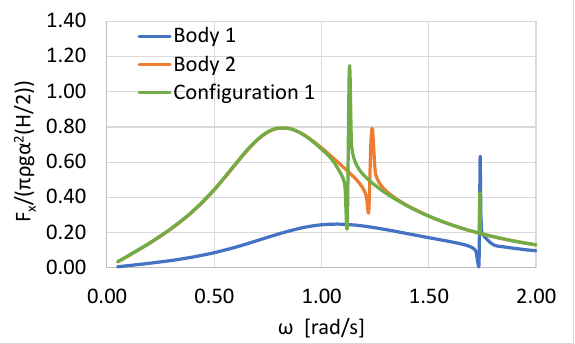
Figure 5. Horizontal exciting forces on the Configuration 1. The results are also compared with the corresponding forces on the isolated toroidal Bodies 1 and 2 .